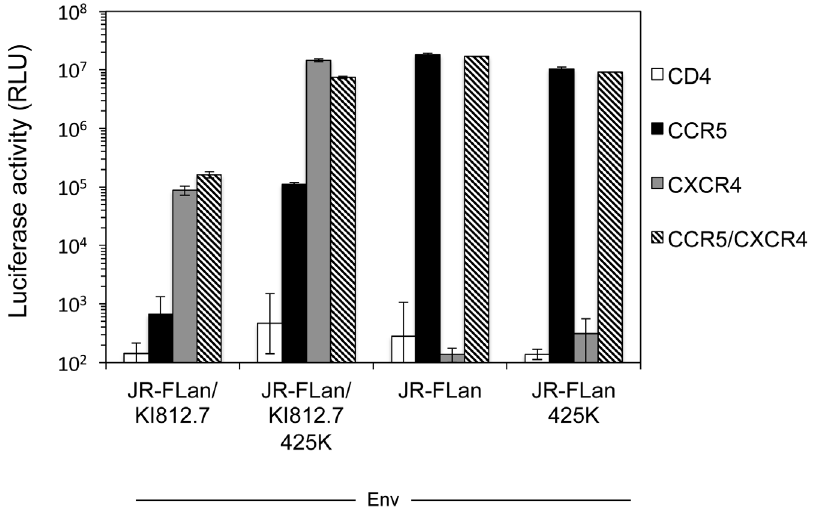
Figure 6. Effect of M425K substitution on JR-FLan Env. Coreceptor usage and entry efficiency of recombinant luciferase-reporter HIV pseudotyped with the indicated Envs were determined using NP2/CD4 cells expressing either CXCR4 or CCR5 and cells expressing both CXCR4 and CCR5, respectively. The cells were infected with the same amount of luciferase-reporter pseudotyped virus (10 ng p24Ag) with the indicated mutations. Luciferase activities were measured at 48 h post-infection. Data are the geometric means 6 SD of triplicate